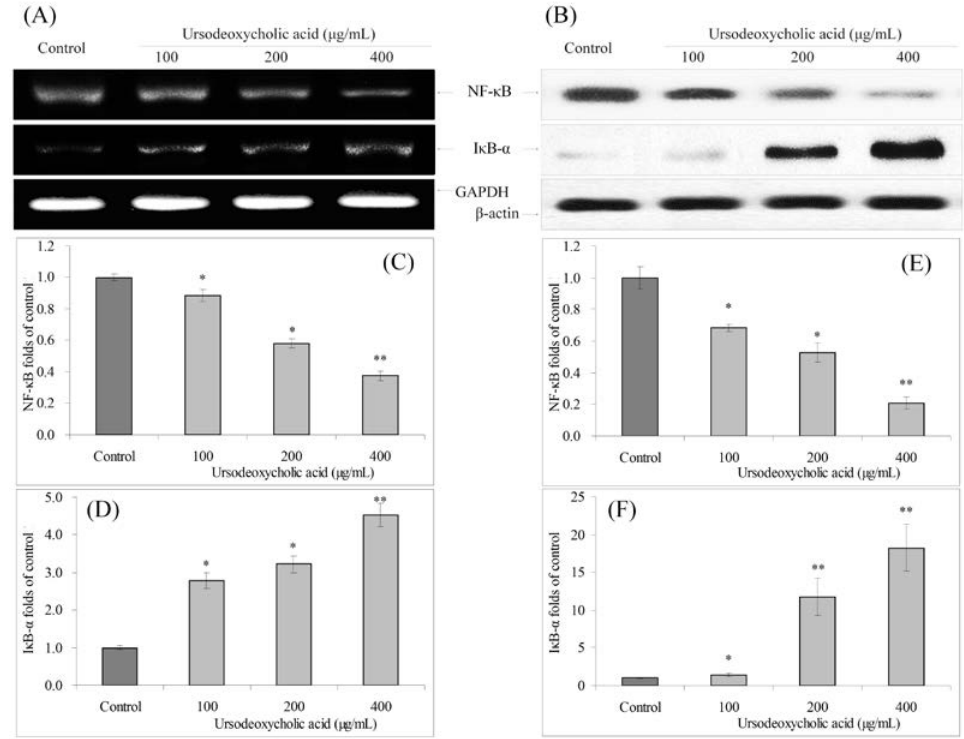
Figure 8. Effects of ursodeoxycholic acid (UDCA) on the mRNA ( A ) and protein ( B ) expression of NF-κB and IκB-α in human oral squamous carcinoma HSC-3 cells. Fold-ratio: gene expression/GAPDH (β-actin) × control numerical value (control fold ratio: 1); ( C ), NF-κB mRNA expression folds of control; ( D ), IκB-α mRNA expression folds of control; ( E ), NF-κB protein expression folds of control; and ( F ), IκB-α protein expression folds of control. * Mean values are significantly different from control ( p < 0.05) and ** mean values are significantly different from control ( p <